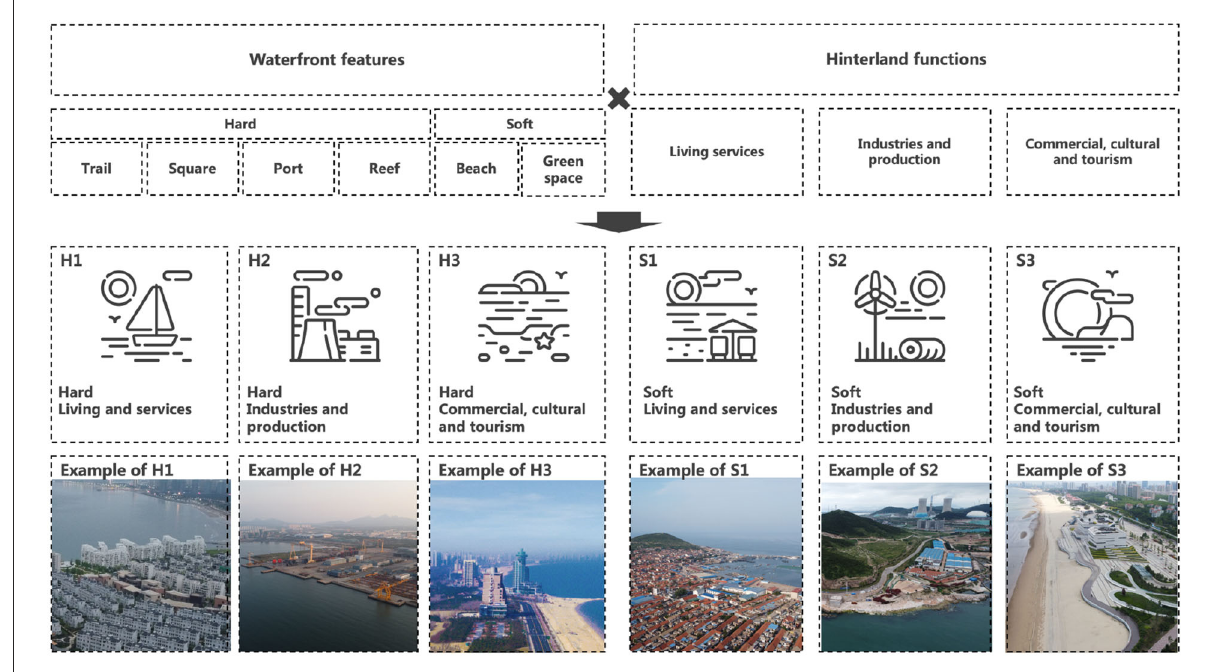
FIGURE10 The classification results of urban coastal zones. The illustration photos were taken by the author.